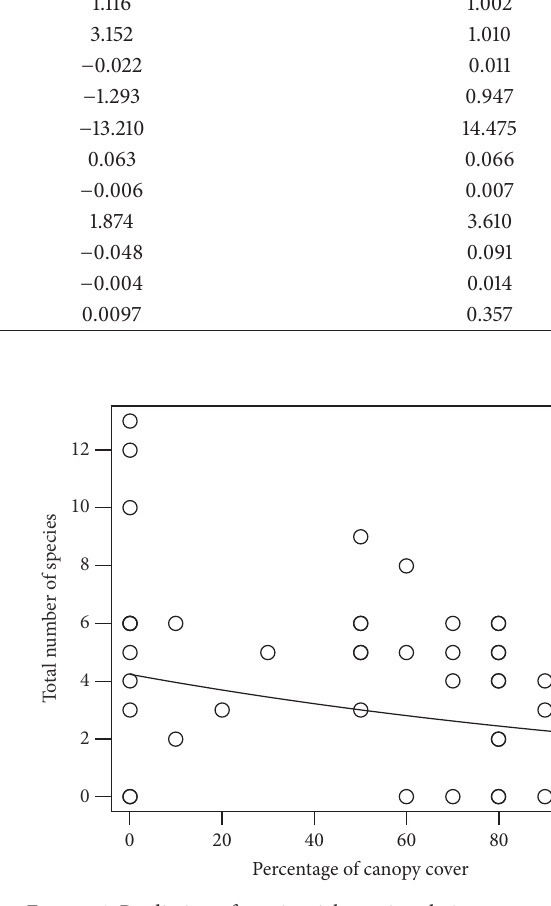
Figure 4: Prediction of species richness in relation to canopy cover based on the coefficients of the best models selected by AIC stepwise